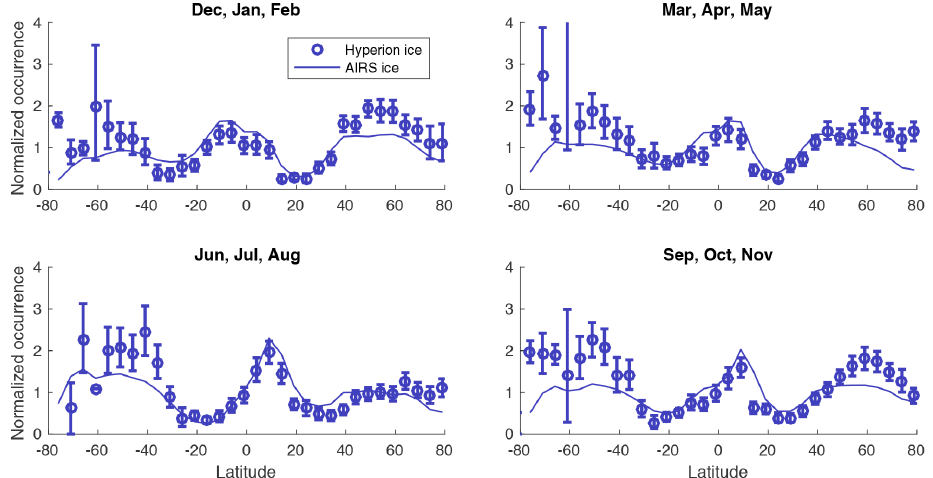
Figure 8. As in Fig. 7, for the ice